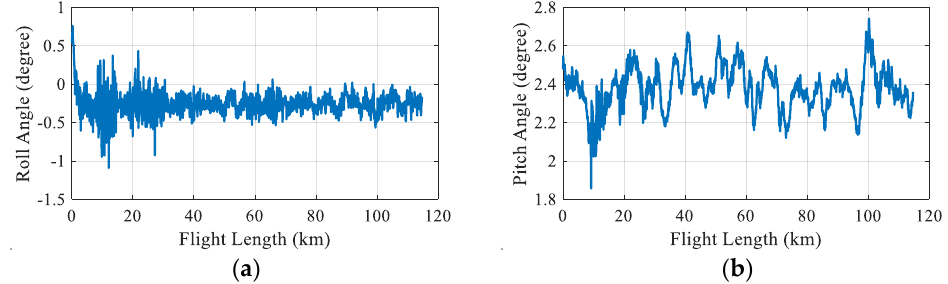
pattern is also different from ordinary altimeter.